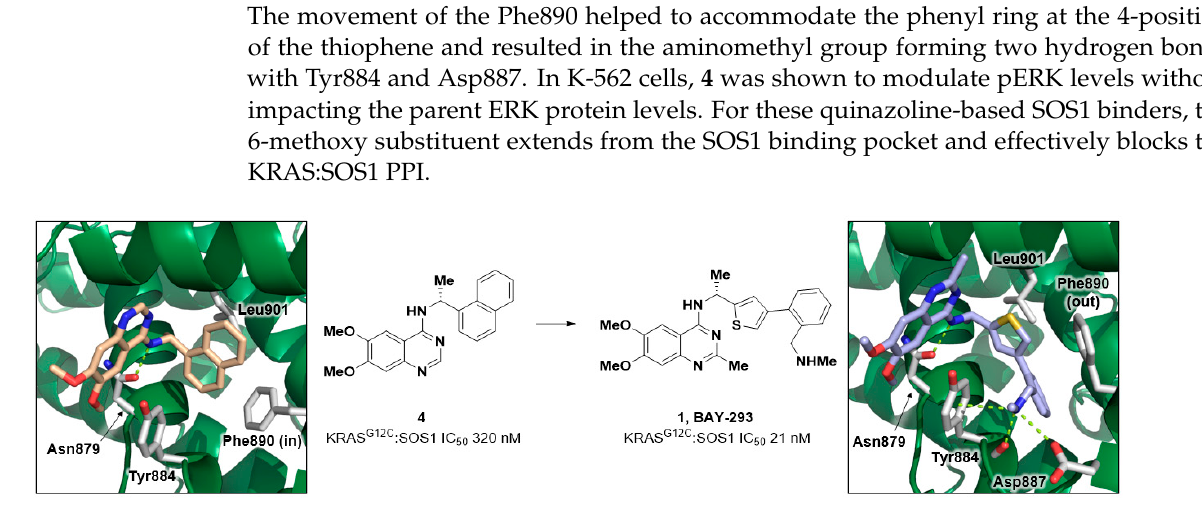
Figure 3. Compound structure of HTS hit 4, leading to the discovery of BAY-293 ( 1 ). X-ray co-crystal structure of 4 bound to SOS1 (PDB 5OVE). A key hydrogen bond between the aniline N-H of 4 and the side chain of Asn879 was observed and the naphthyl group 4 was bound in a hydrophobic pocket formed by Leu901 and Phe890. X-ray co-crystal structure of 1 bound to SOS1 (PDB 5OVI). Phe890 side chain rotates from the back of the pocket towards the front of the pocket. The basic amine makes an ionic interaction with Asp887, a hydrogen bond with the backbone carbonyl of Tyr884, and a cation- π interaction with the sidechain of Tyr884.